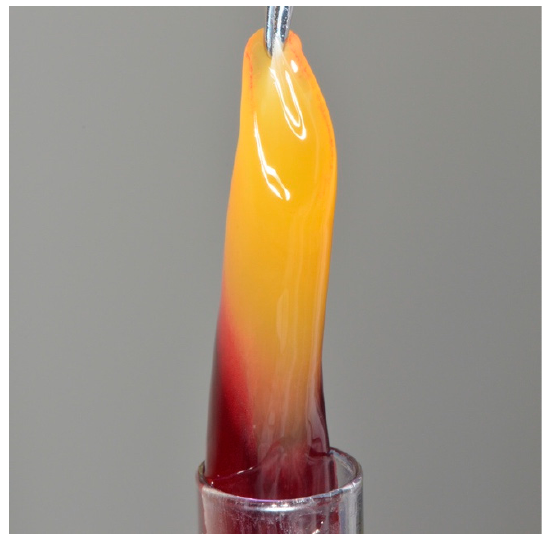
Figure 5. Autogenous-oriented PRF membrane.